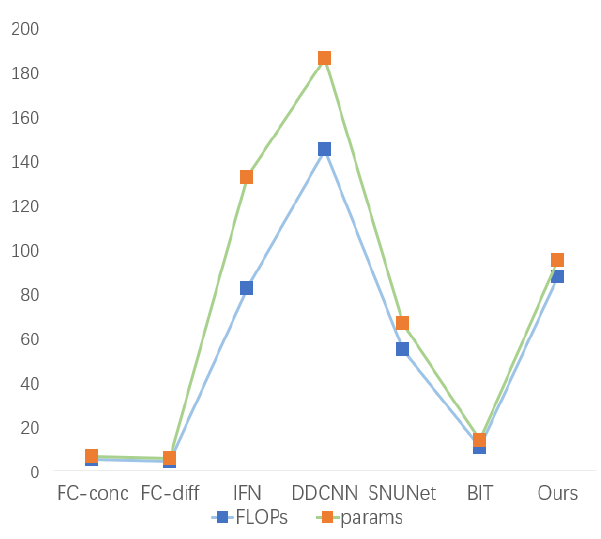
Figure 10. FLOPs and params.